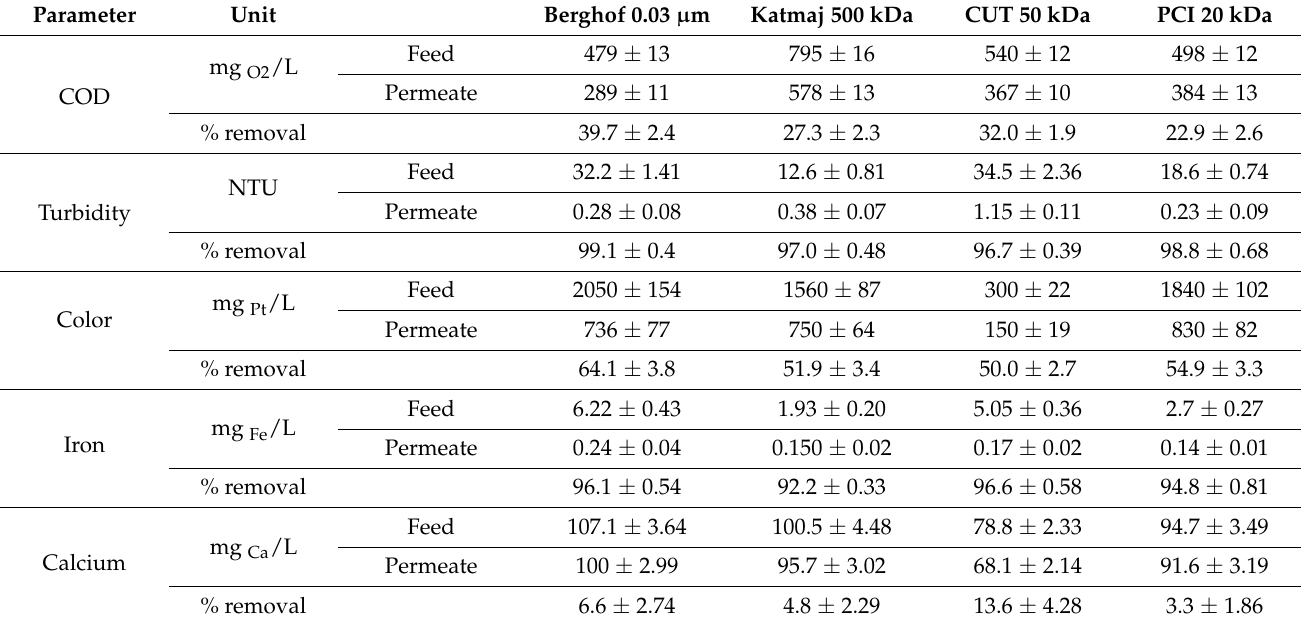
Table 6. Degree of removal of the selected components during low-pressure filtration (T = 25 °C, w = 4 m/s, Δ P = 0.2 MPa). Parameter Unit